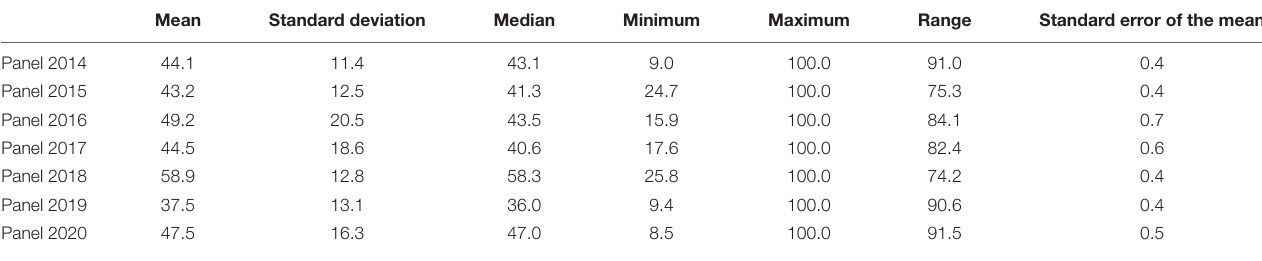
TABLE 1 | Statistical analysis of the relative area under the disease progress curve for spot blotch evaluated in different panels. Mean Standard